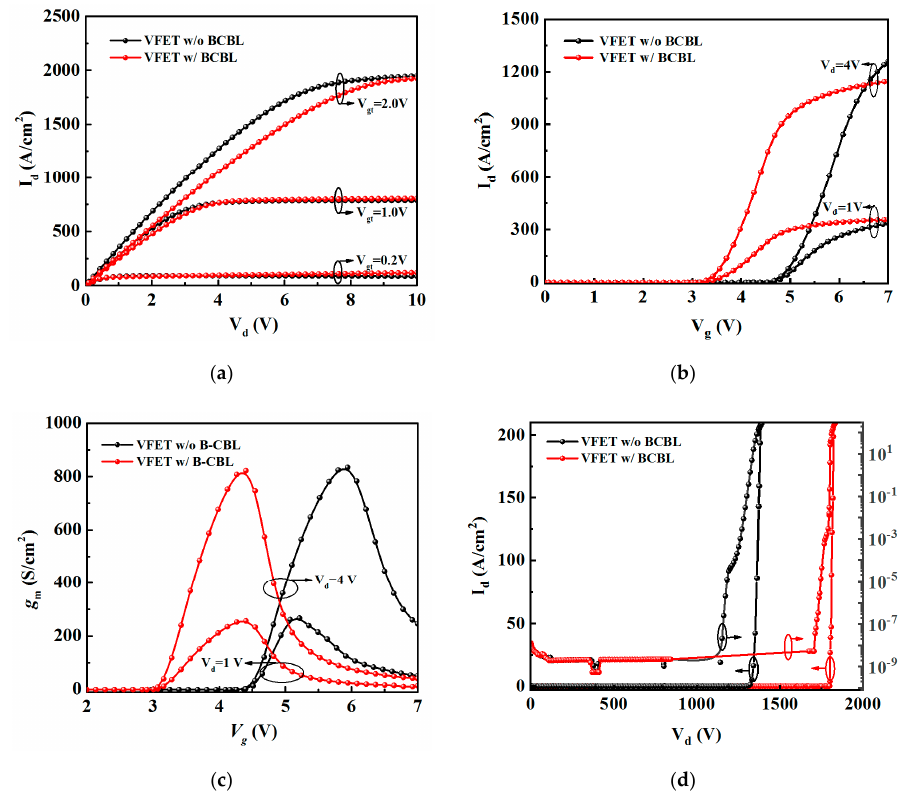
Figure 11. Comparisons of the typical ( a ) output dc I d –V d curves, ( b ) transfer I d –V g curves, ( c )